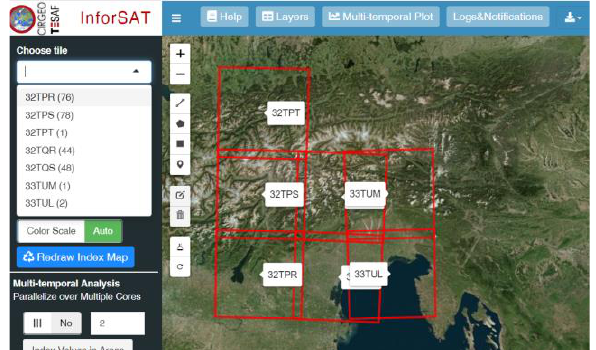
Figure 2. InforSAT’s implementation with some S2